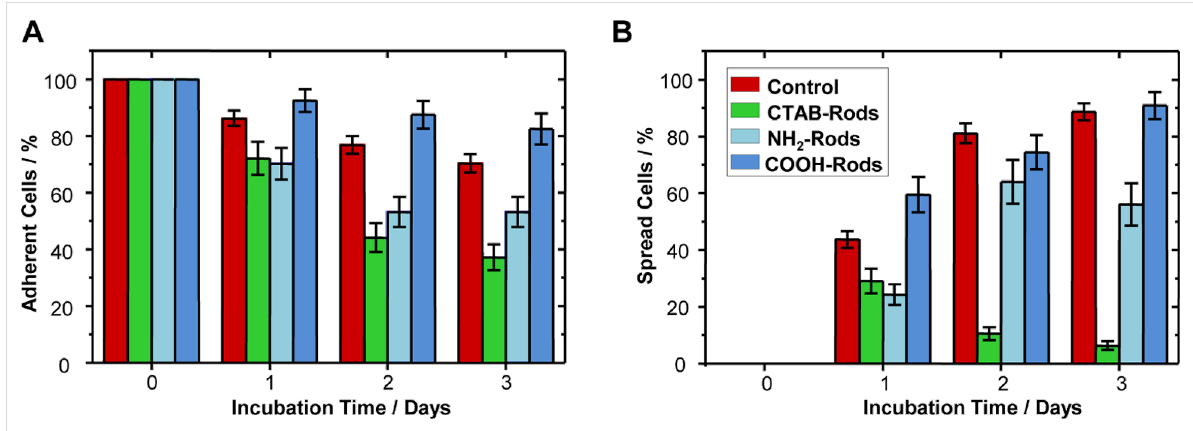
Figure 3: Adherence and proliferation of cells grown on nanoparticle-decorated substrates indicated by cell adhesion and spreading on the substrate. (A) Compared to the untreated control consisting of cells growing on a bare glass slide (red), the adherence of cells on CTAB nanorods (green) and NH 2 –PEG nanorods (light blue) is reduced by 45% and 30%, respectively, while adherence appears unaffected for COOH–PEG rods (blue). Note that in the control sample a few cells detached, since not every single seeded cell properly develops after initial attachment to the substrate. (B) Results indicating that over time, more and more cells increase their spreading area in the untreated control sample (cells growing on bare glass slide (red)). The same behavior was observed for cells growing on COOH–PEG nanorods (blue). In the presence of NH 2 –PEG nanorods (light blue), proliferation was reduced by 40% after 3 days, whereas proliferation of the tracked cells practically stopped within 3 days for CTAB rods (reduction compared to untreated control by 95%) (green). The data are presented as median and standard error of the